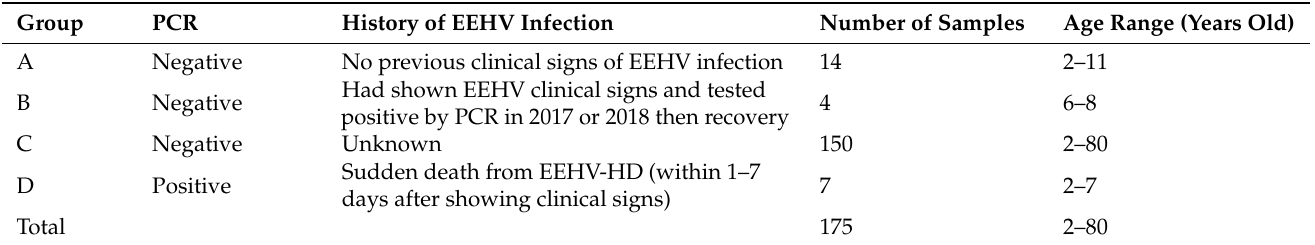
Table 1. Categorization of elephant sera used to develop an in-house nonstructural protein